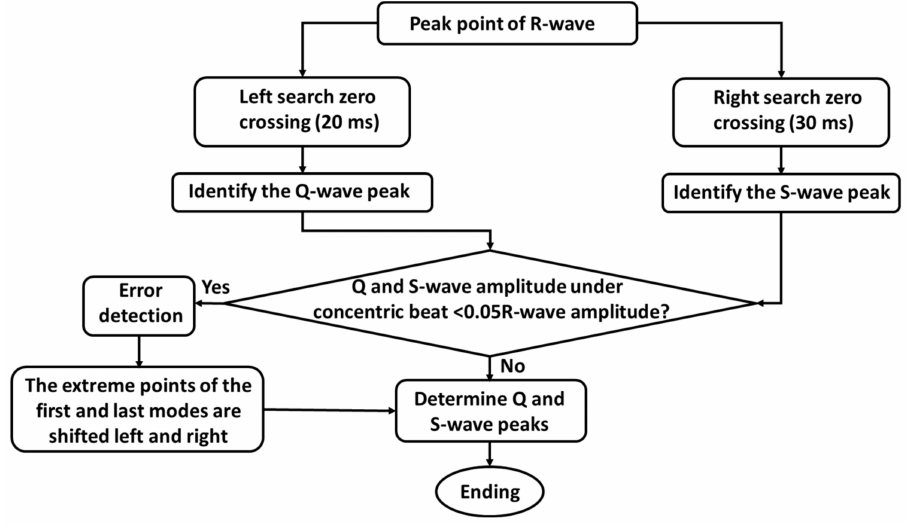
Figure 2. Q-waves and S-waves detection of ECG